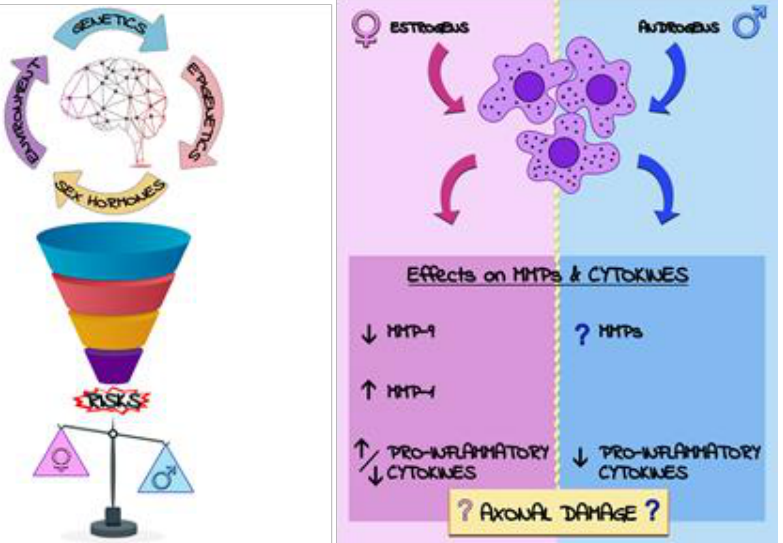
Figure 4. Factors concurring to different MS risk in females with respect to males. Genetics (e.g., HLA-DRB1*1501 allele), epigenetics (e.g., TLR7, CD40L, FoxP3), environment (e.g., smoking and Vitamin